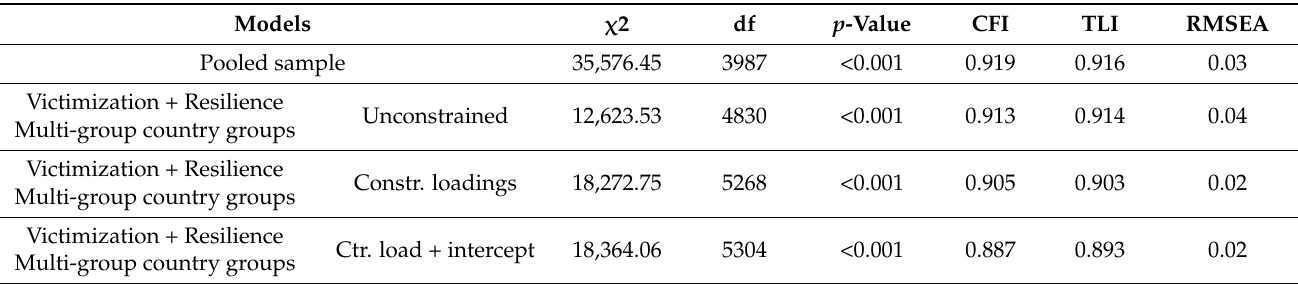
Table 6. Multigroup invariance analysis among